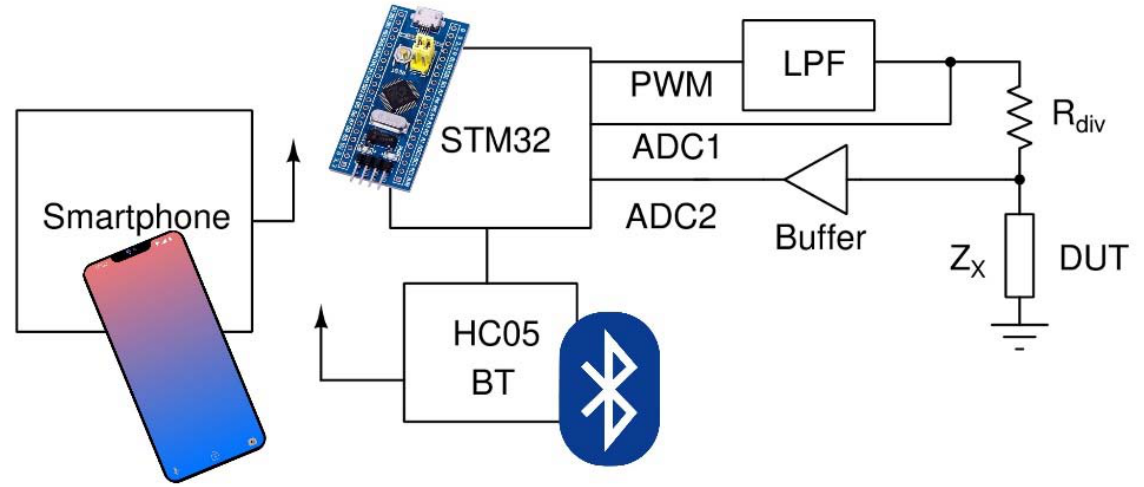
Figure 1. Working principle of the circuit.